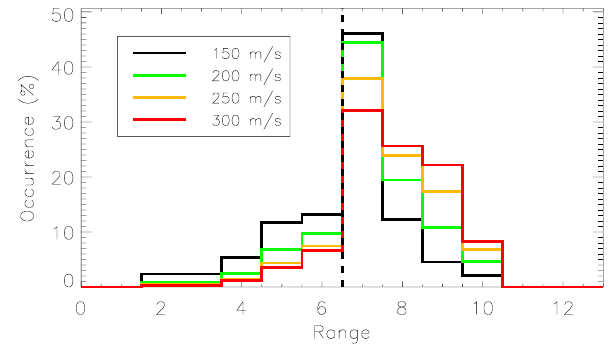
Fig. 4. The percentage occurrence of the location of the first range gate above the spectral width boundary within the simulated data set, as estimated by algorithm 2. The results are presented for the 4 different spectral width thresholds used in the analysis (150, 200, 250, and 300 m/s).